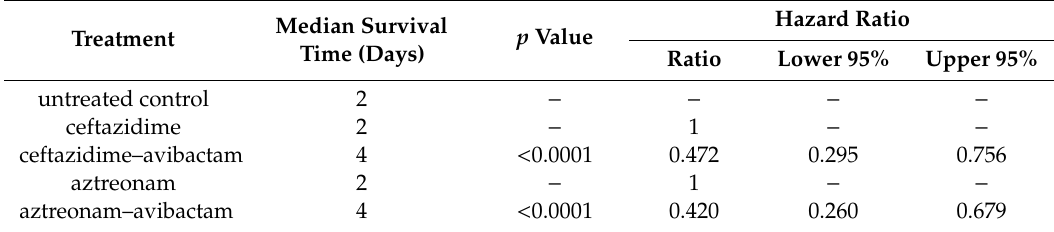
Table 2. In vivo C. elegans statistical data.